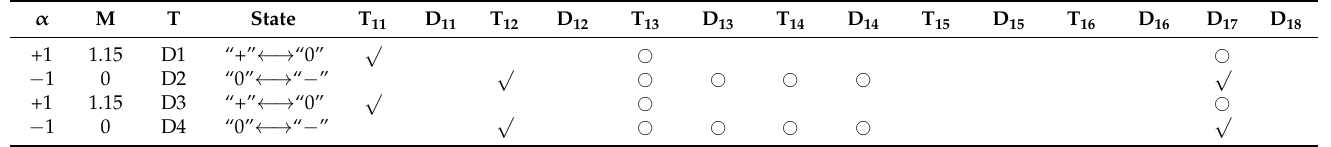
Table 4. D-NPC switching loss table.